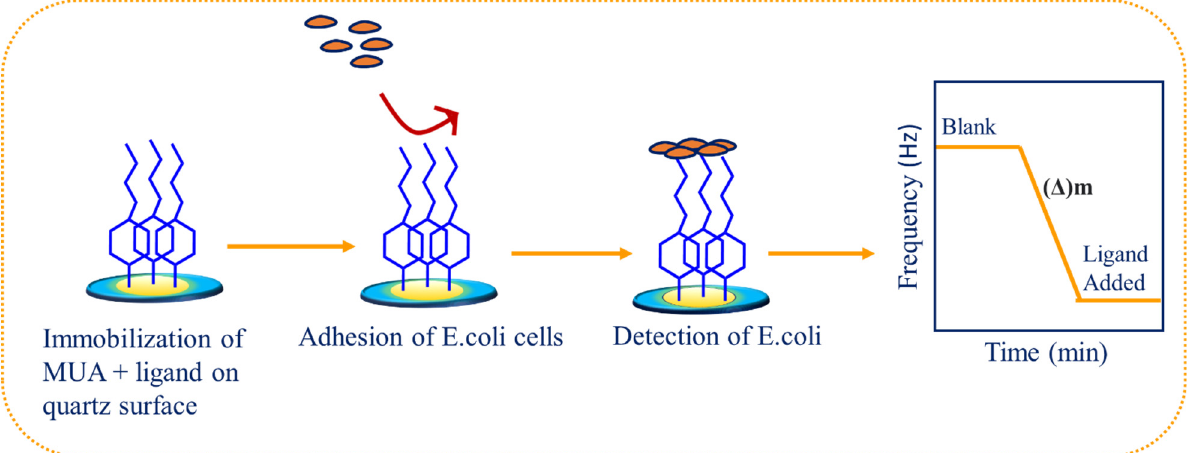
Scheme 1. Schematic representation of immobilized MUA and mannose derivatives on gold quartz crystal. ( A ) 4-TNM ( B ) 4-NMBA.